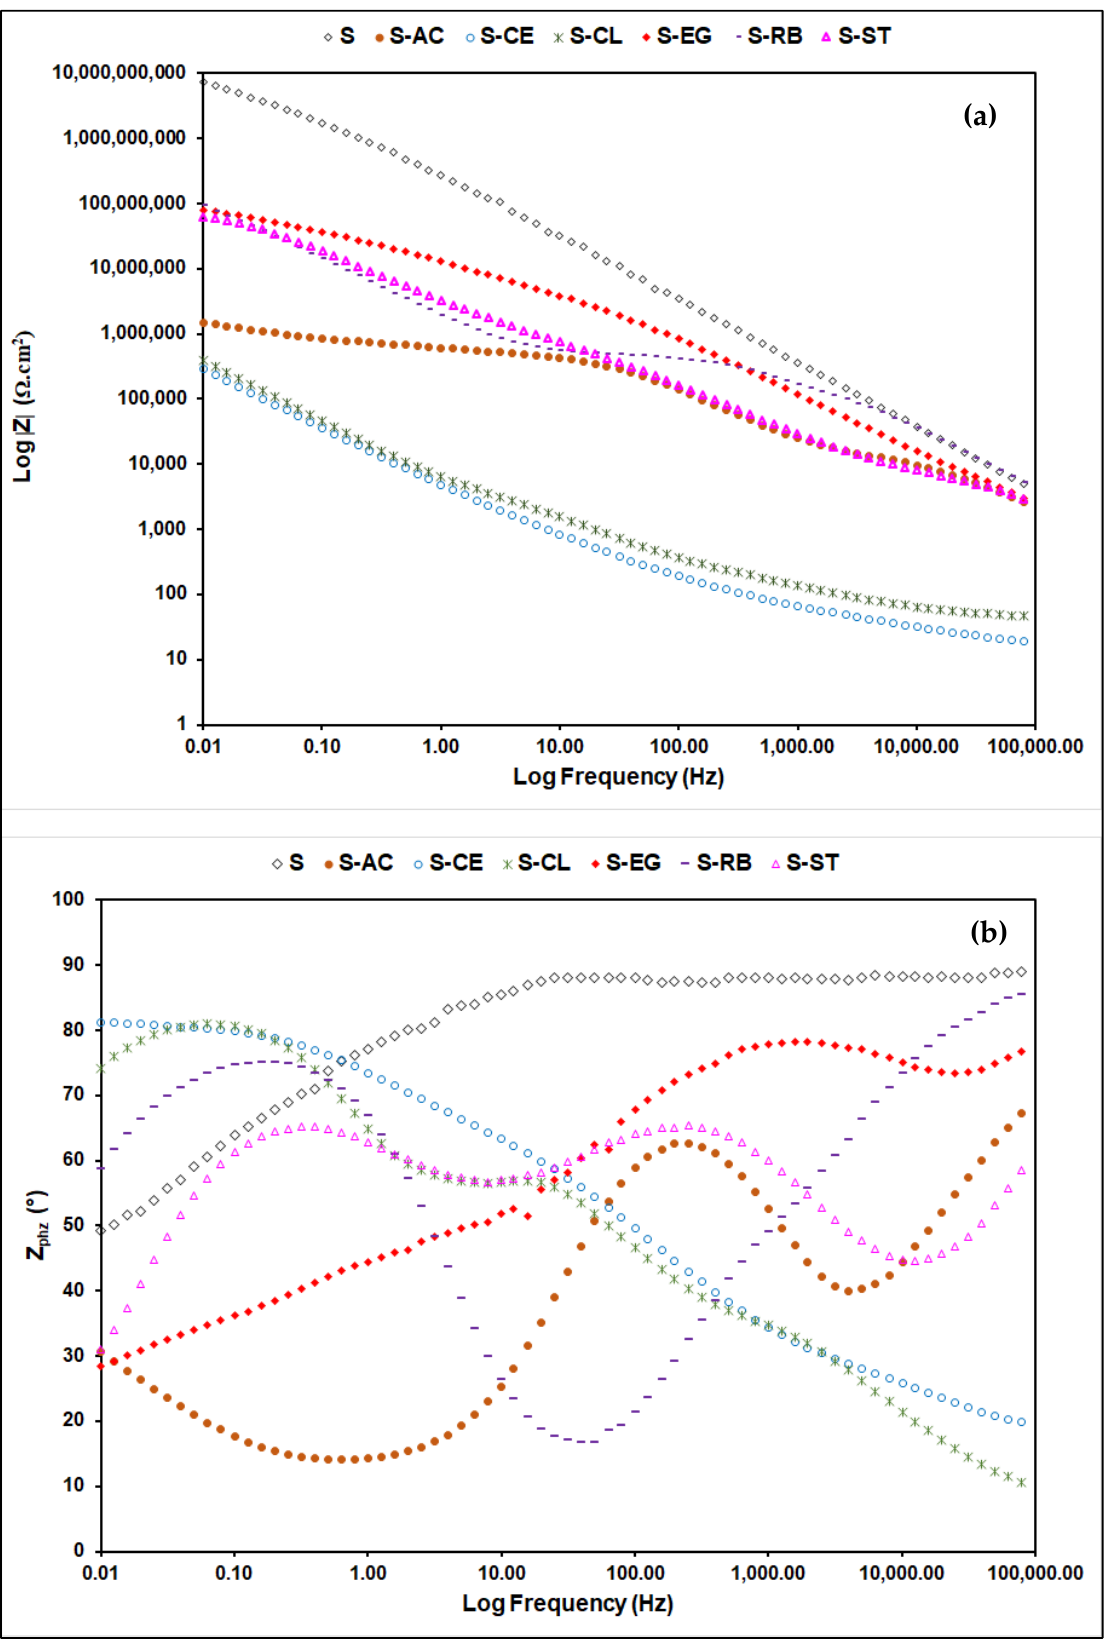
Figure 7. ( a ) EIS and ( b ) Bode phase plots of all coated samples on AA3003 substrate after 30 days of exposure to the 3.5 wt.% NaCl solution.